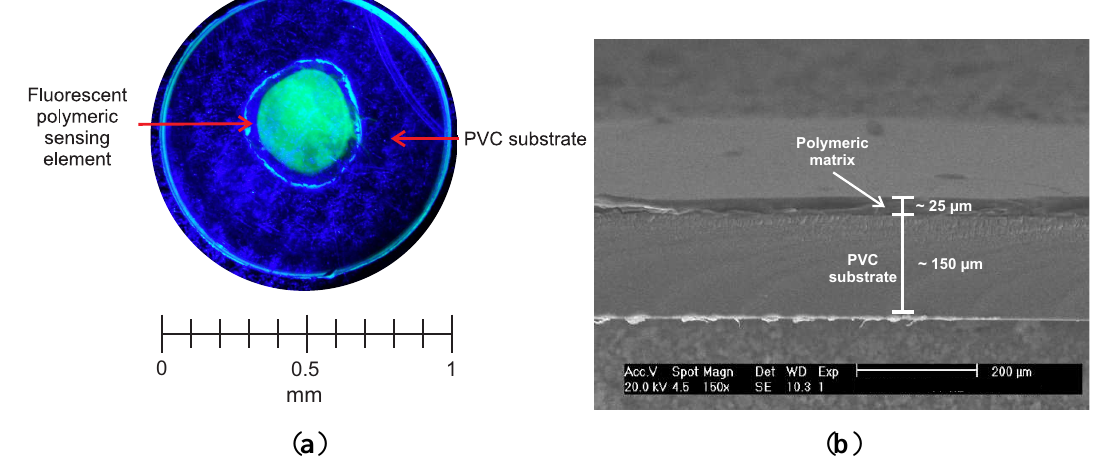
Figure 3. ( a ) Top-view picture of the hydrophilic polymer matrix including the fluorescent indicator, used as the sensing element, excited by a blue LED. ( b ) SEM cross-section picture of the hydrophilic polymer matrix including the fluorescent indicator, used as the sensing